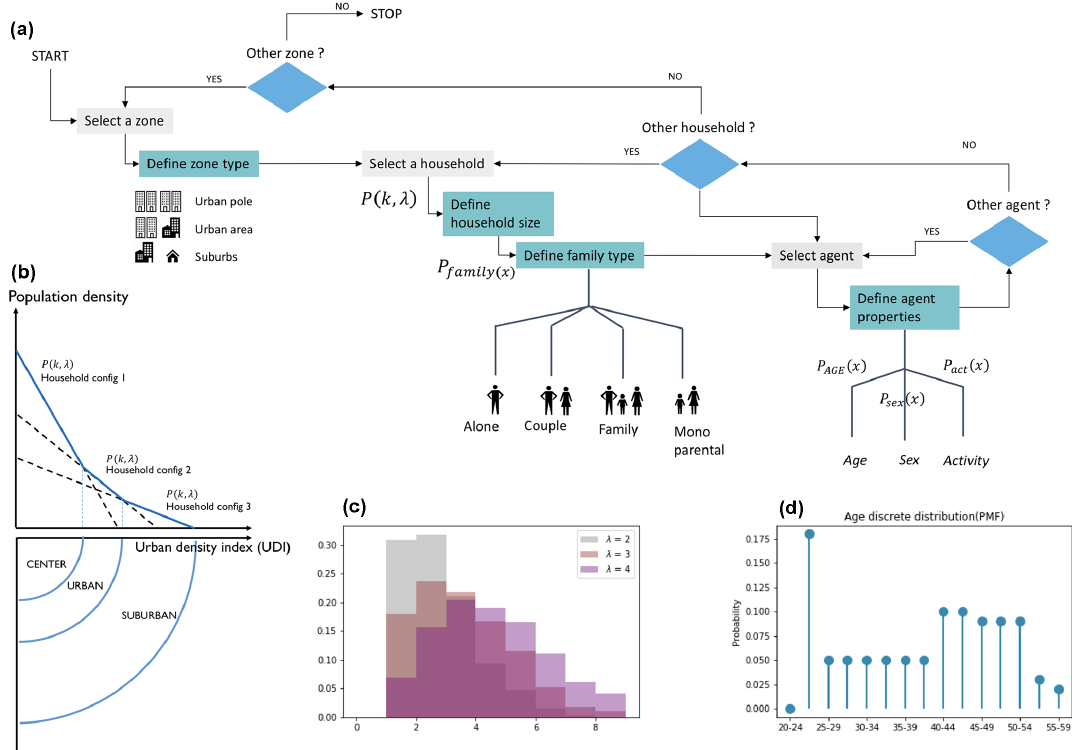
Figure 2. (a) Synthetic population generator GAIA model operating flowchart. (b) Schematic representation of the urban density index (IDU). (c) Example of the household size probability distribution according to a truncated Poisson distribution. (d) Example of a representation of the distribution of the probability of mass function (PMF) of the age of an agent living alone.